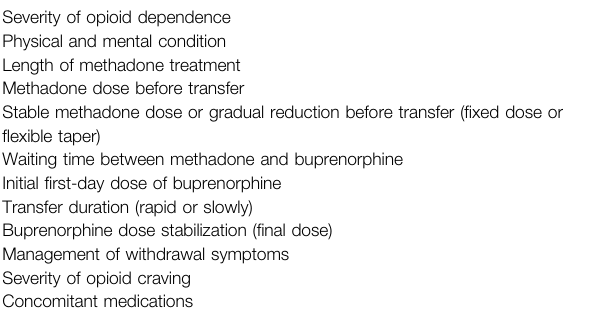
TABLE 1 | Transfer of patients from methadone to buprenorphien: relevant factors. Severity of opioid dependence Physical and mental condition Length of methadone treatment Methadone dose before